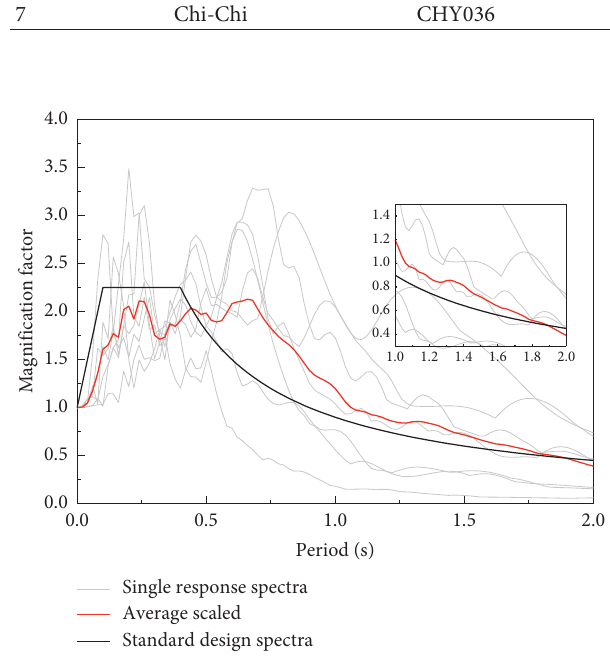
Figure 6: Spectra of selected ground motion.